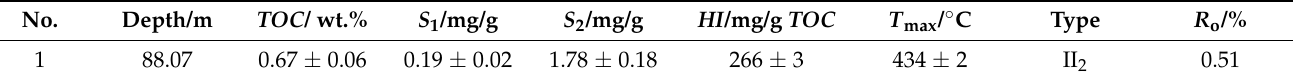
Table 3. Geochemical analysis results of source-rock samples in Well Laikong 2, Jiaolai Basin [9].